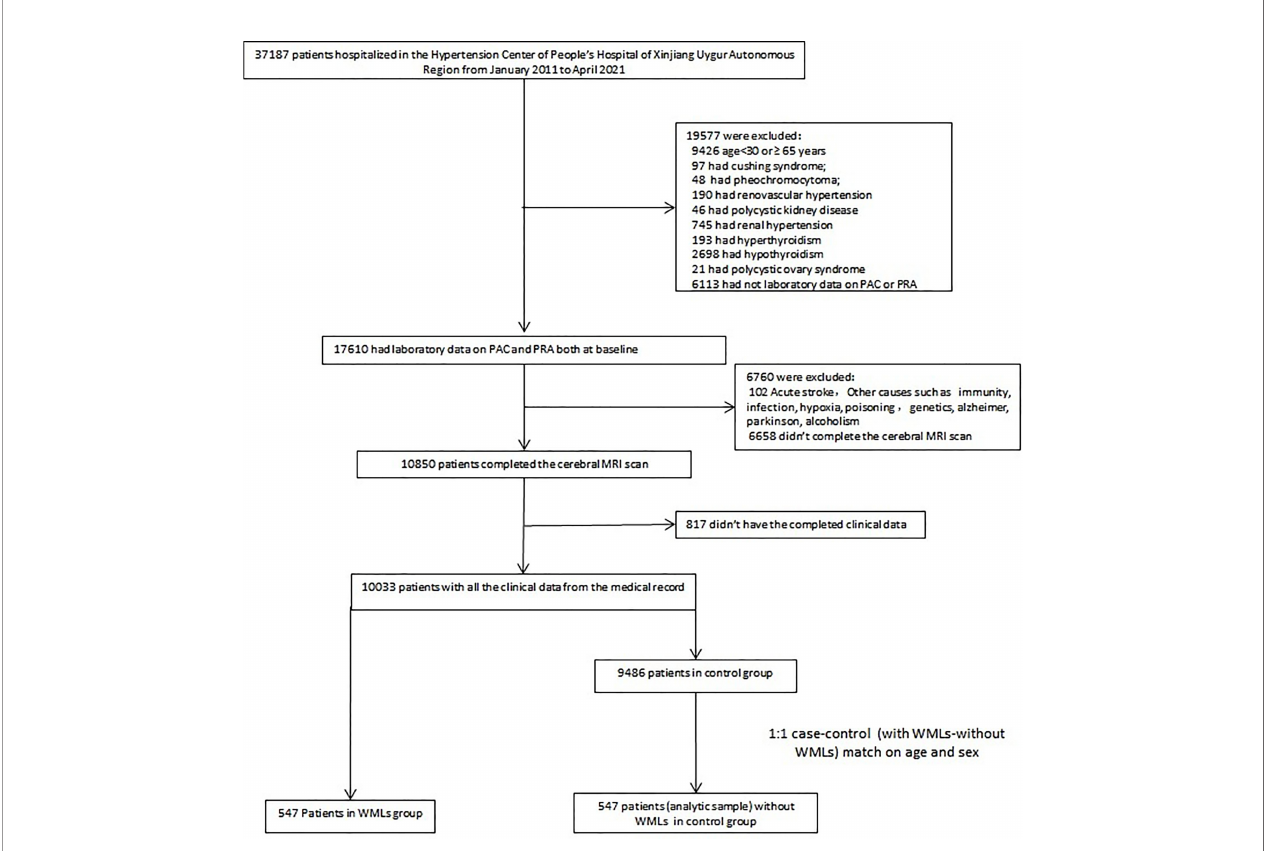
FIGURE 1 | Flowchart visualizing the selection process of the patients. PAC, plasma renin activity; PRA, plasma aldosterone concentration; WMLs, white matter